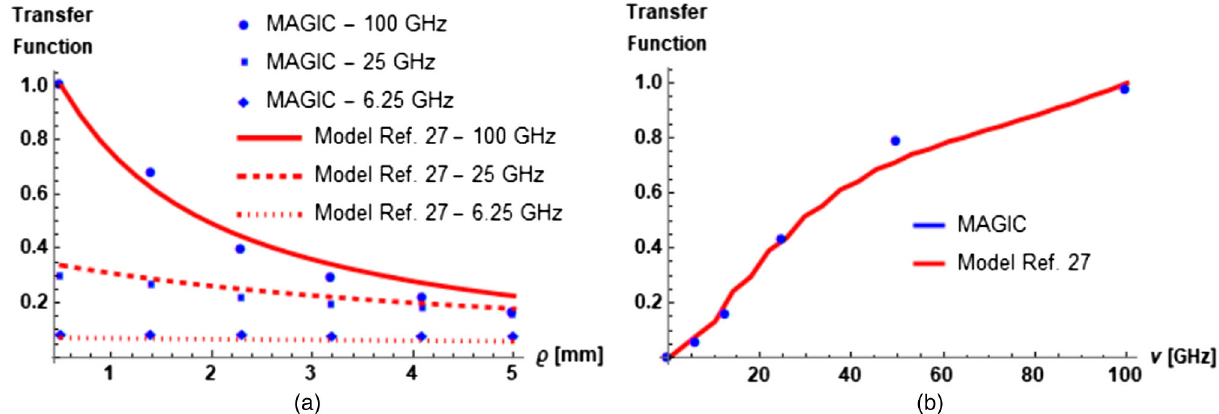
FIG. 4. (a): Transfer function of conical radiator ( ε ¼ 2 . 1 ) with internal radius ϱ ranging from 0.5 mm to 5 mm. (b): Transfer function of the hollow conical radiator ( ε ¼ 2 . 1 ) as a function the radiated